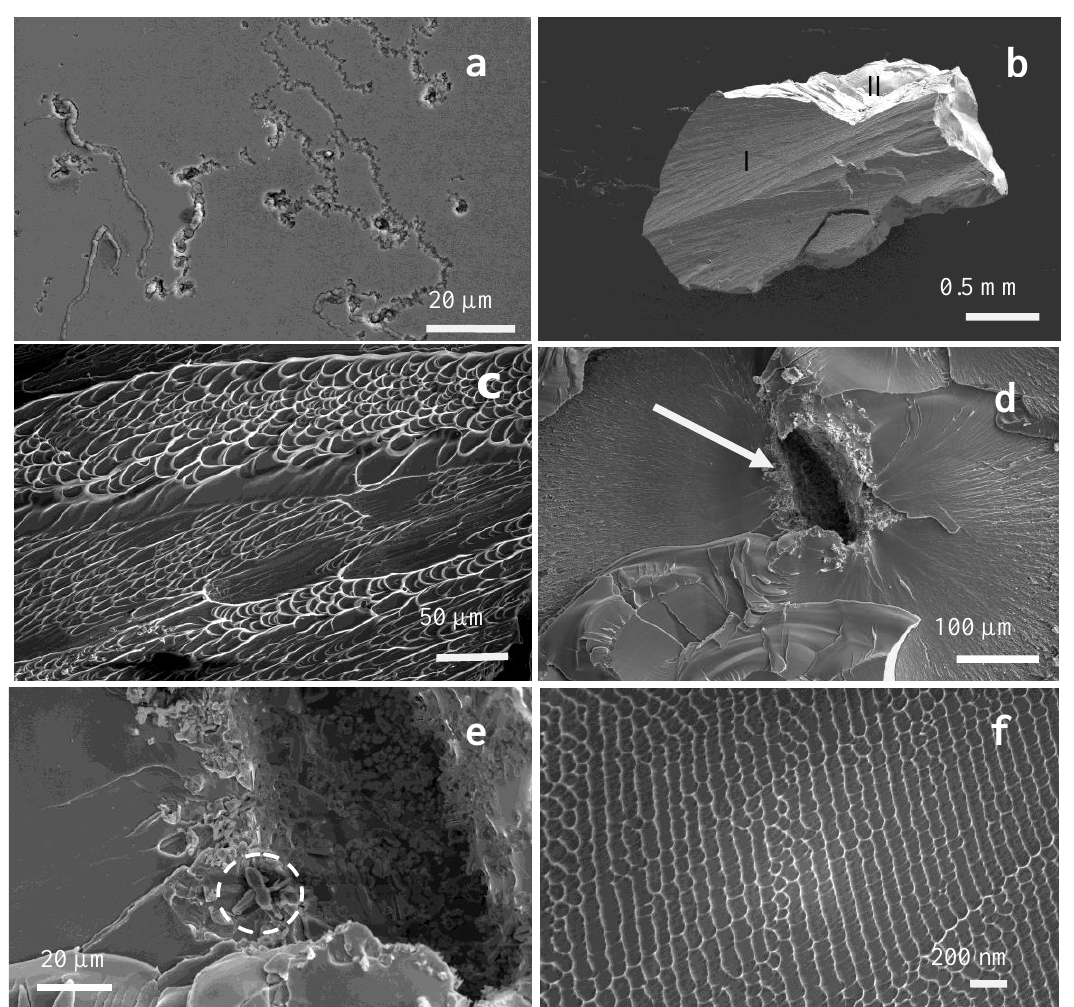
Figure 5. ( a ) Mixed oxides of Mg and Tb in a Mg piece of the alloy after compression testing. Two regions, I and II are seen, that correspond to shear failure and brittle fracture respectively. ( c ) Region I shows vein patterns with a size of ~10 μm. ( d ) Region II consists of a flat, mirror-like fracture surface. Clear crack initiation sites are visible, as pointed by the arrow. ( e ) A closer view of a crack initiation site, which is a cluster of oxide particles. The dotted circle highlights an individual oxide particle. ( f ) Typical nano-scale fractographic features are seen in region II. Reprinted from [45], with permission from